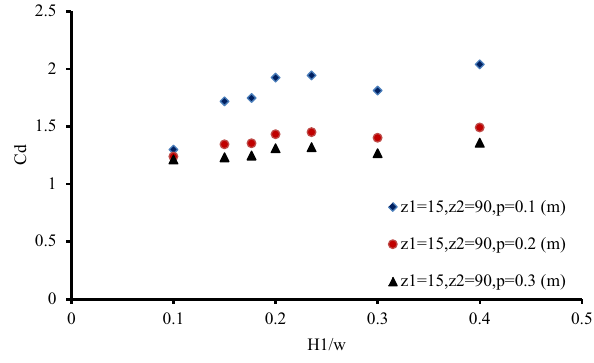
Fig. 10 Discharge coefficients for z upstream slopes